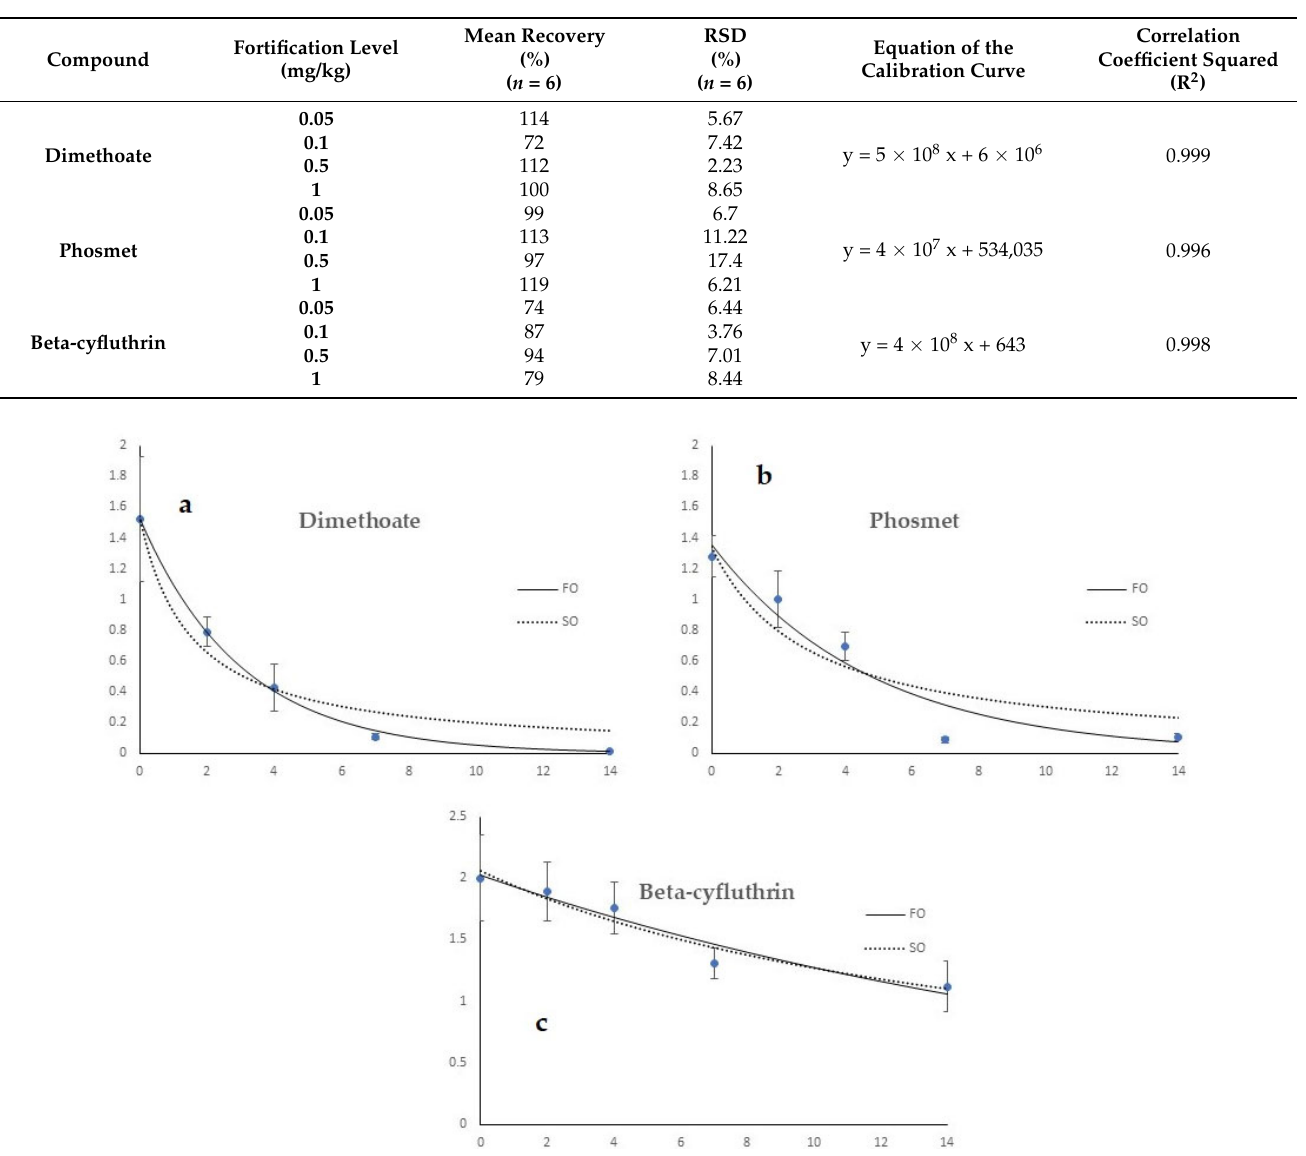
Table 1. Accuracy (Recoveries, %), precision (RSDs, %) values and linearity results calculated after the fortification of blank samples.